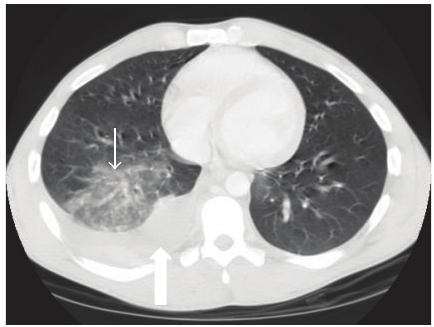
Figure 2: Pulmonary contusion and hemothorax in a patient who fell down of his bike. Axial MDCT in lung window at the level of left cardiac chamber shows right lower lung contusion (thin arrow) associated with ipsilateral hemothorax (thick arrow).